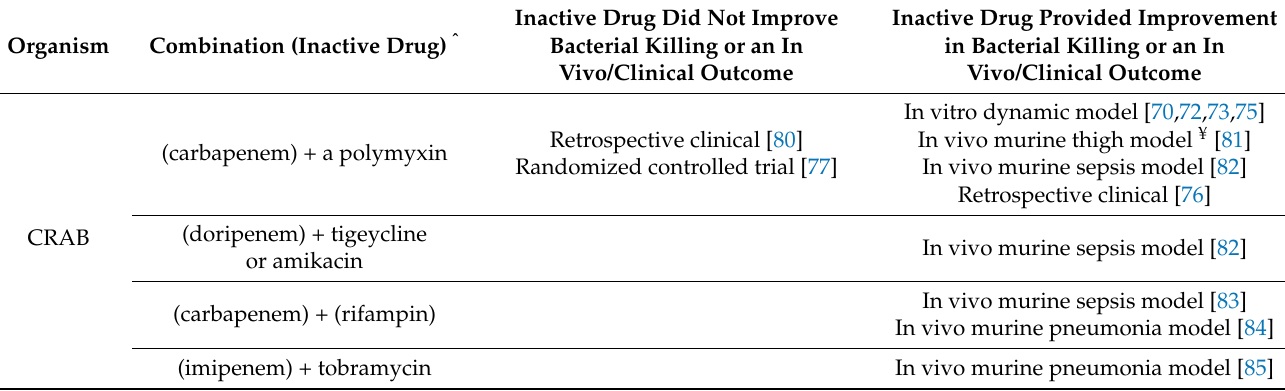
Table 3. Summary of studies that investigated antibacterial combinations against A. baumannii that included at least one drug that was inactive individually. Studies are reported in the table if the combination was investigated using a dynamic in vitro model, an in vivo model, or the investigation was completed in the clinic. Susceptibility studies, checkerboard analyses, and static time-killing experiments are not reported in the table due to the preliminary nature of the experiments and the extensive combinatorial permutations that are difficult to summarize